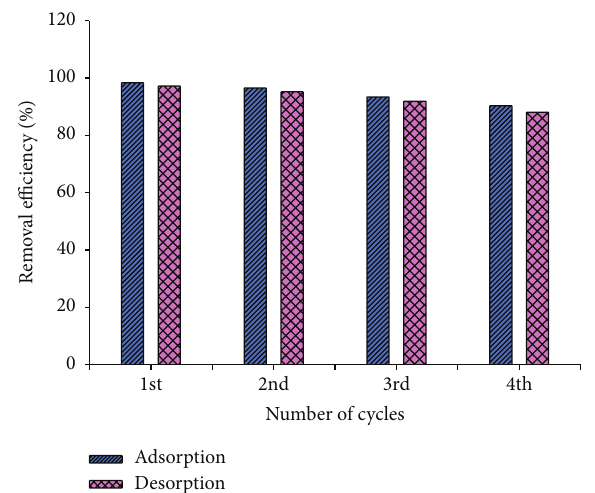
Figure 12: Adsorption/desorption efficiency of lead ion onto CRSD during different cycles (concentration 10 mg/L, flow rate 15mL/min, and bed depth